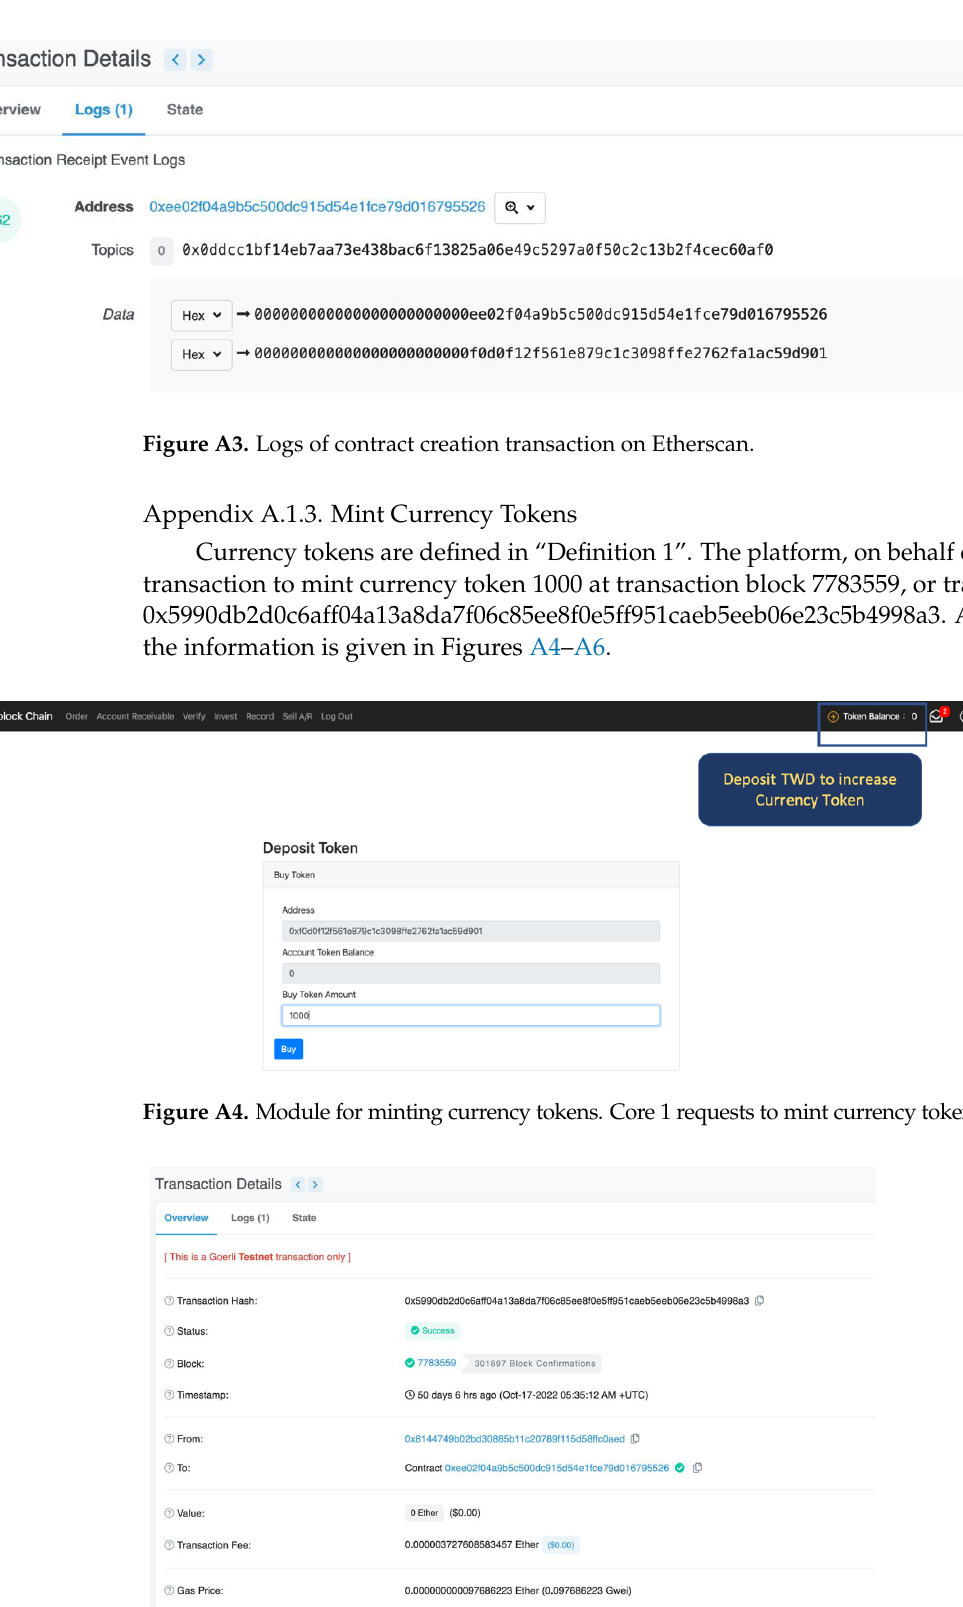
Figure A5. Proof of minting currency tokens on Etherscan.